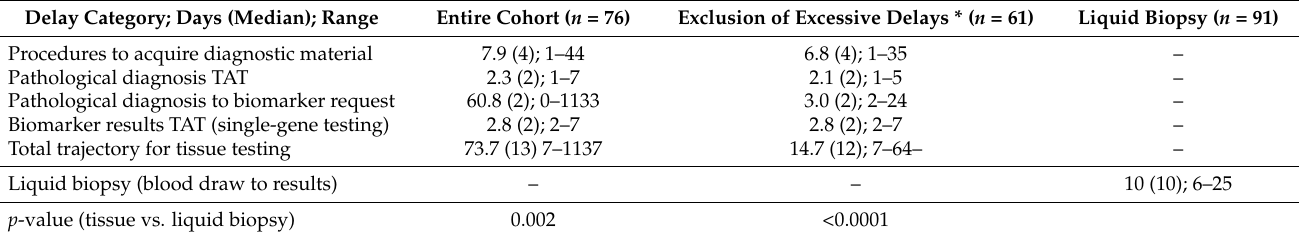
Table 5. Summary of time-lapse for the main steps to obtain biomarker results in the cohort. Delay Category; Days (Median); Range